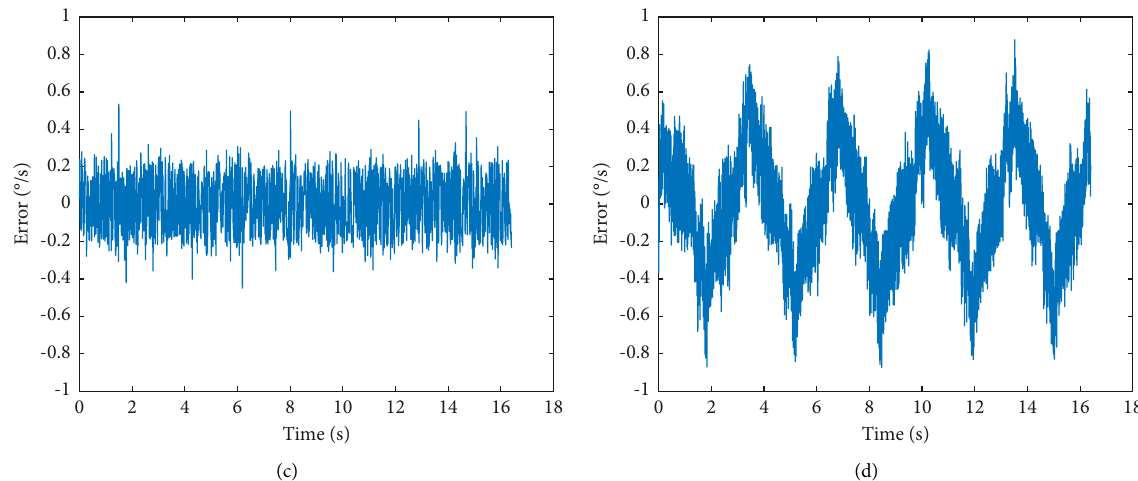
Figure 6: Simulation results under 90 ° /s. (a) Elbow joint torque. (b) Comparison between reference speed, speed response of the FOFPID controller, and speed response of the PID controller. (c) Error between reference speed and speed response of the FOFPID controller. (d) Error between reference speed and speed response of the PID